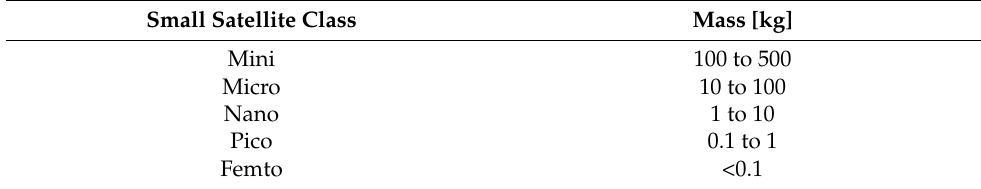
Table 1. Small satellite classification according to their mass adapted from